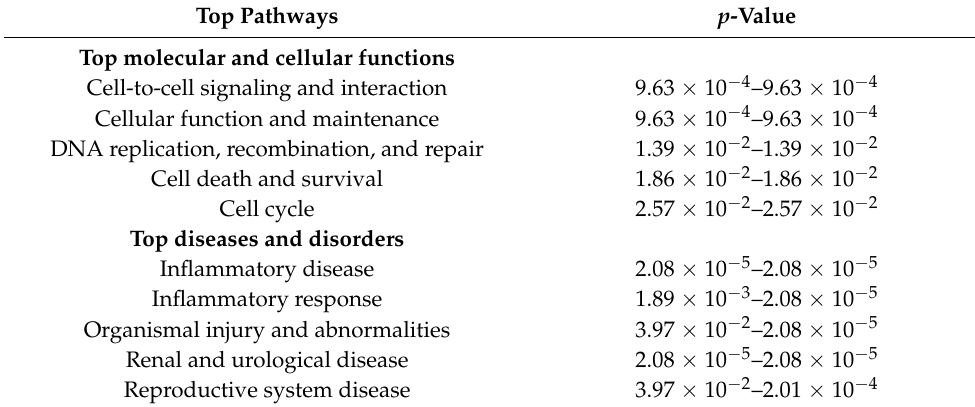
Table 3. IPA pathways associated with differentially expressed miRNAs.